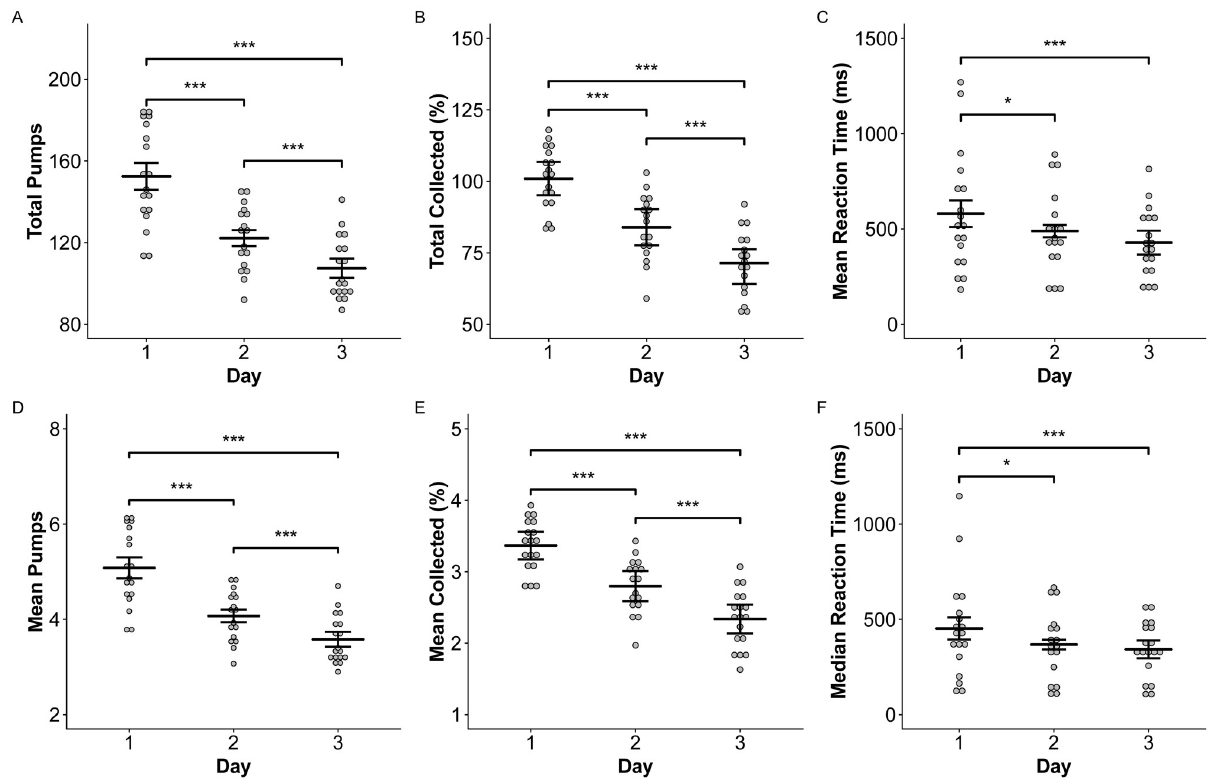
Fig 5. Risk-taking behavior identified by the BART decreases after acclimatization. The total number of pumps (A), mean number of pumps (D), total reward collected (B), mean reward collected (E), mean reaction time before each pump (C), and median reaction time before each pump (F) decreased over three days at high altitude. Means and 95% confidence intervals are presented. Asterisks indicate significant differences across days at p < 0.05 ( � ), p < 0.01 ( �� ), and p < 0.001 ( ���